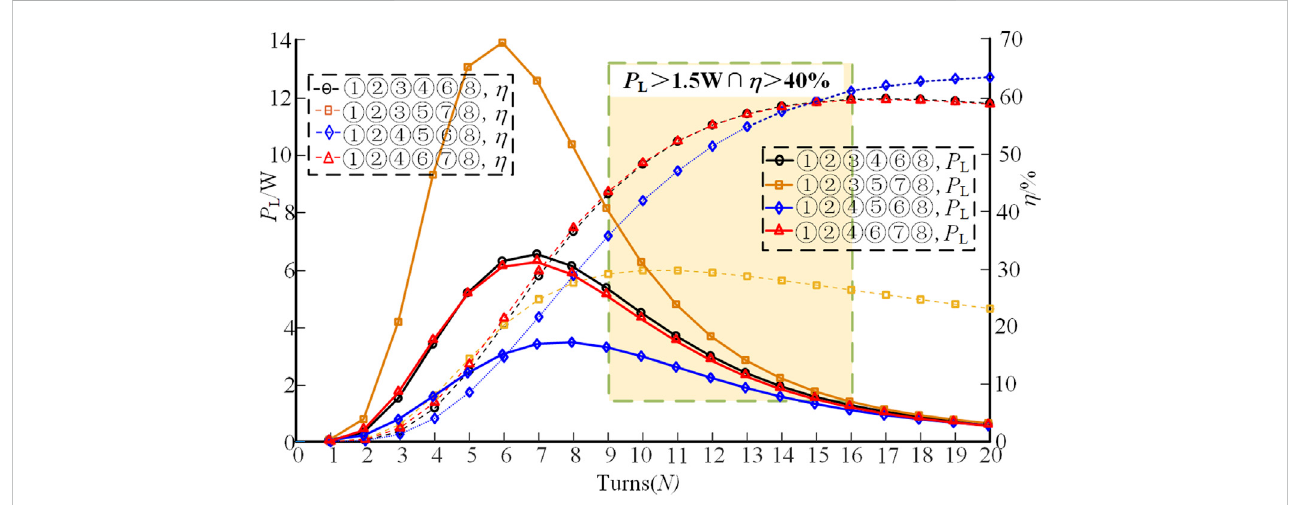
FIGURE 5 The performance of the four-relay coil WPT system varies with N or position.